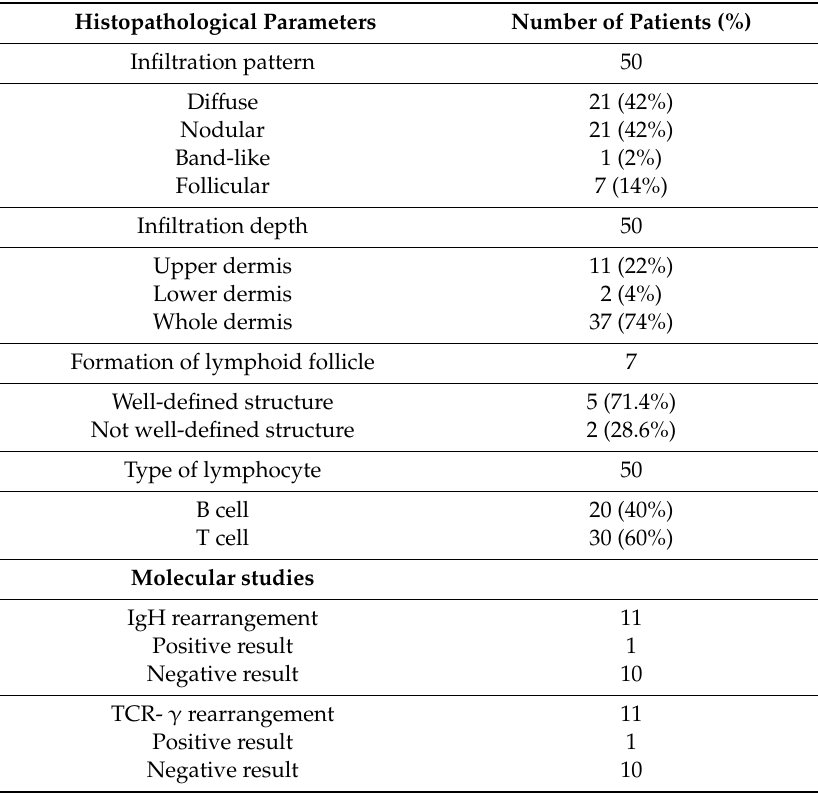
Table 2. Histopathological features of cutaneous lymphoid